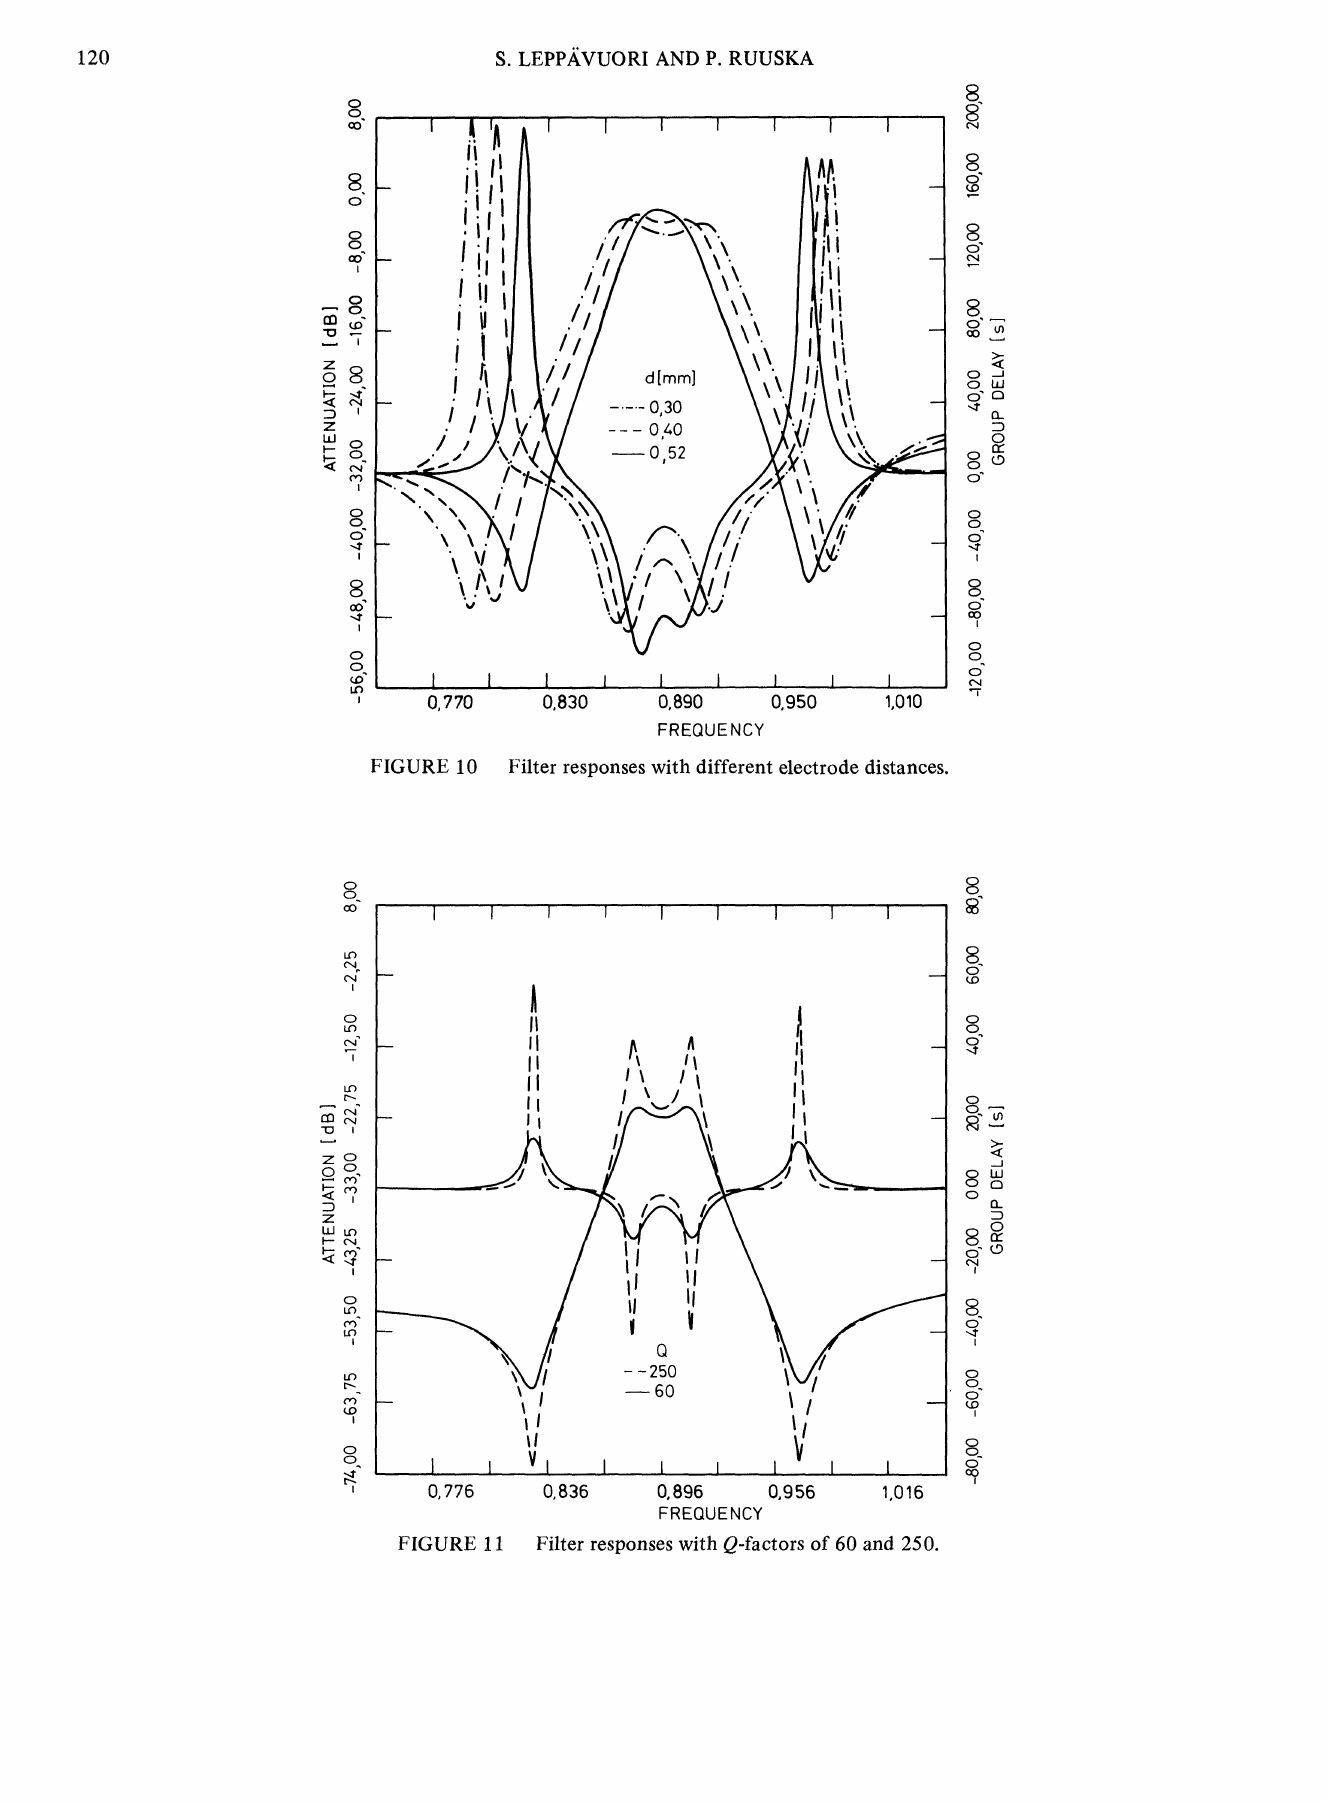
FIGURE 11 Filter responses with Q-factors of 60 and